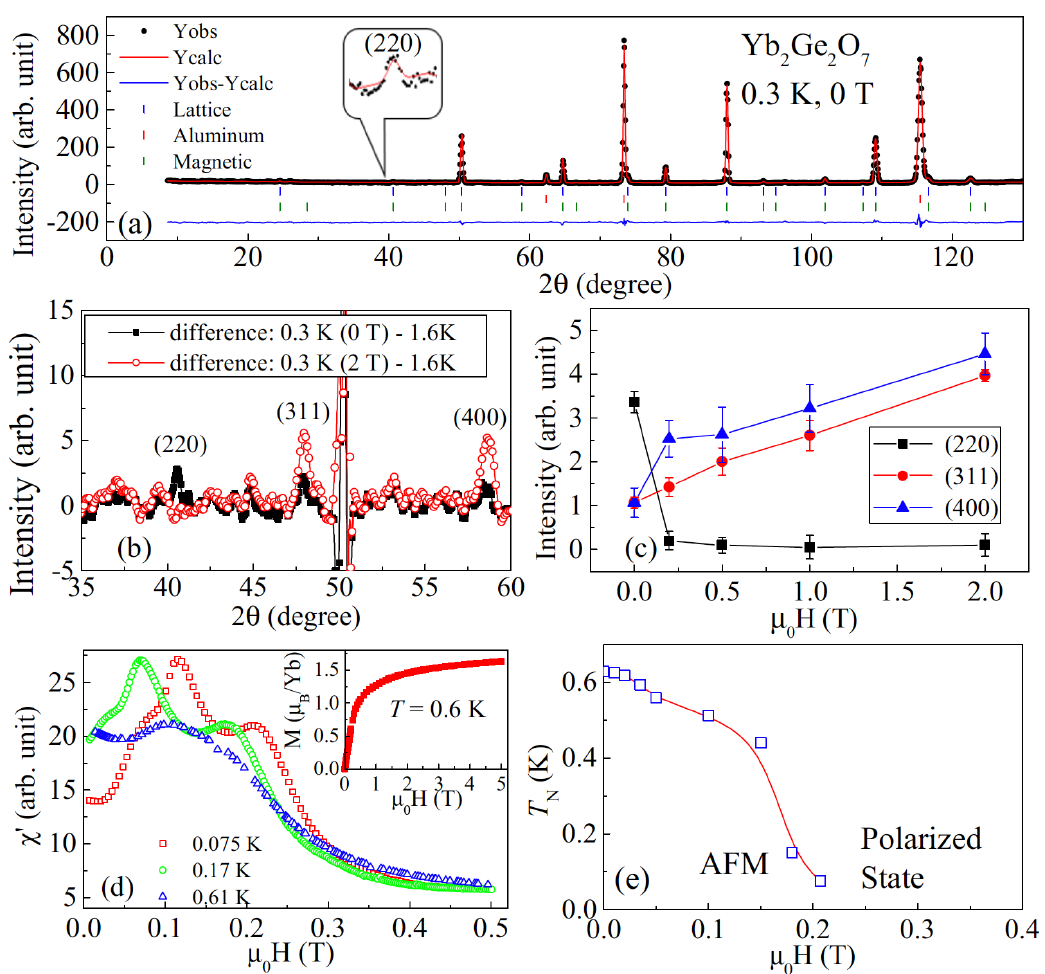
Figure 12. (color online) All data for Yb 2 Ge 2 O 7 . ( a ) Elastic neutron scattering pattern and Rietveld refinement at T = 0.3 K and H = 0 T. ( b ) The difference between the patterns measured at 0.3 K (with H = 0 and 2 T) and 1.6 K. ( c ) The field dependence of the (220), (311), and (400) Bragg peaks intensities at 0.3 K. ( d ) The ac susceptibility at different temperatures. Inset: The dc magnetization measured at 0.6 K. ( e ) The magnetic phase diagram. From Ref.